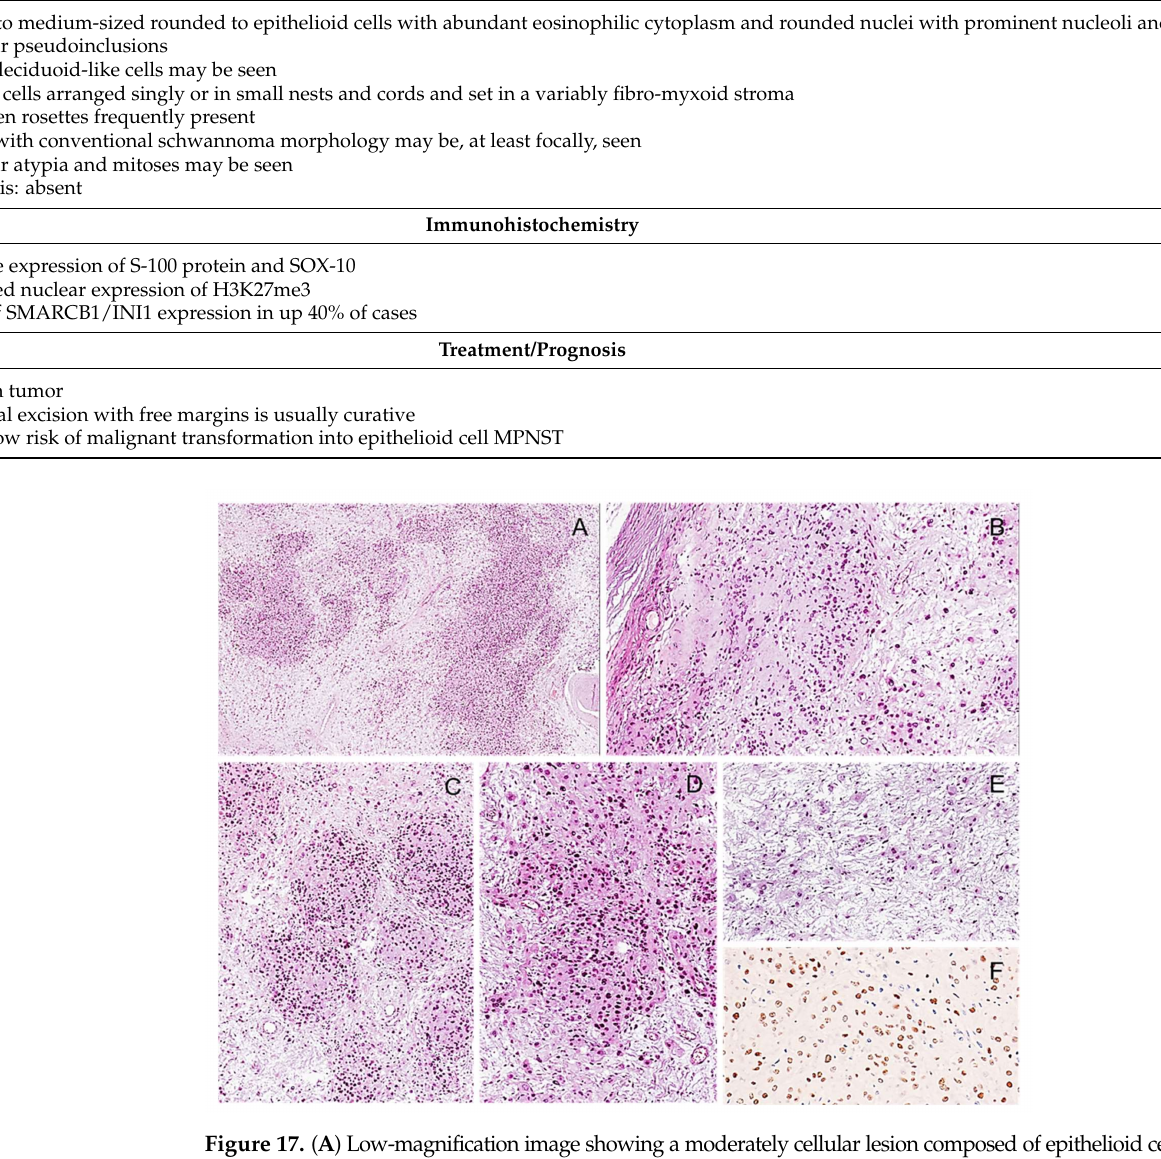
Figure 17. ( A ) Low-magnification image showing a moderately cellular lesion composed of epithelioid cells set in a myxoid stroma. ( B ) At higher magnification, small- to intermediate-sized rounded to epithelioid cells with rounded hyperchromatic nuclei and abundant pale/eosinophilic cytoplasm and well-defined cellular borders are seen. ( C ) Neoplastic cells are arranged in small nests and cords. ( D ) Tumor cells may occasionally exhibit nuclear pleomorphism. ( E ) Epithelioid cell schwannoma may contain a variable amount of large-sized deciduoid-like cells. ( F ) Diffuse immunoreactivity for SOX10 is